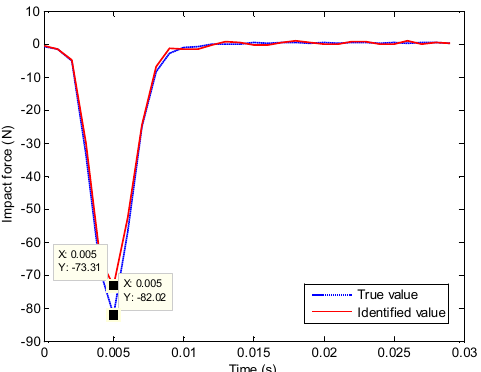
Figure 8. Impact force identification with time window.